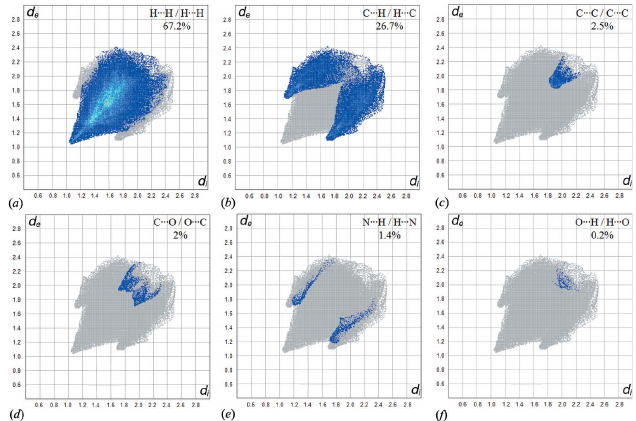
Figure 5 Two-dimensional fingerprint plots for ( a ) H (cid:3)(cid:3)(cid:3) H (67.2%), ( b ) C (cid:3)(cid:3)(cid:3) H/